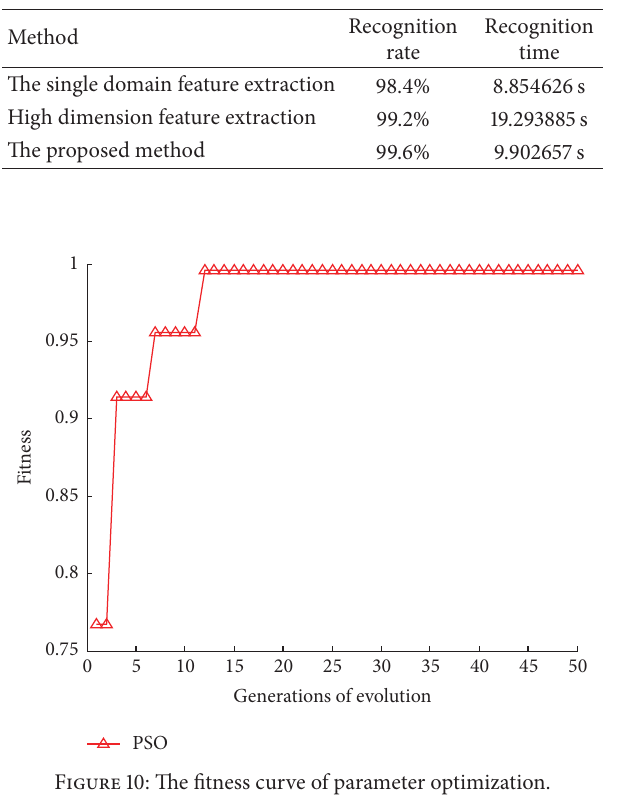
Figure 10: The fitness curve of parameter optimization.